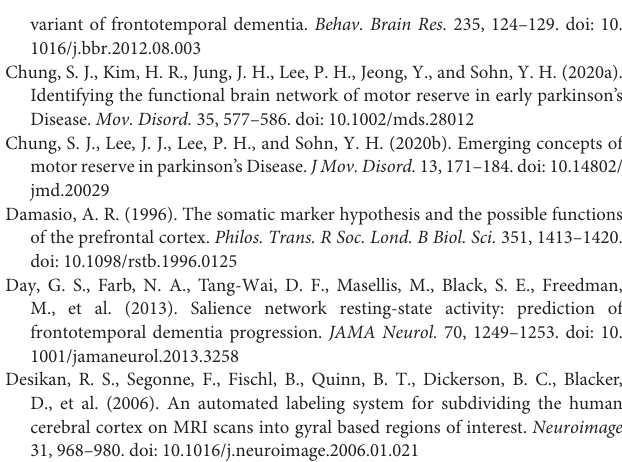
Supplementary Figure 1 | Relationship between the behavior reserve marker for negative symptoms (nBR marker) and occupation complexity. Scatterplots showing relationship between nBR marker and occupational complexity. nBR markers were not significantly correlated with (A) complexity of data ( R = − 0.013, p = 0.982), (B) complexity of people ( R = 0.115, p = 0.779), and (C) complexity of things ( R = − 0.796, p =